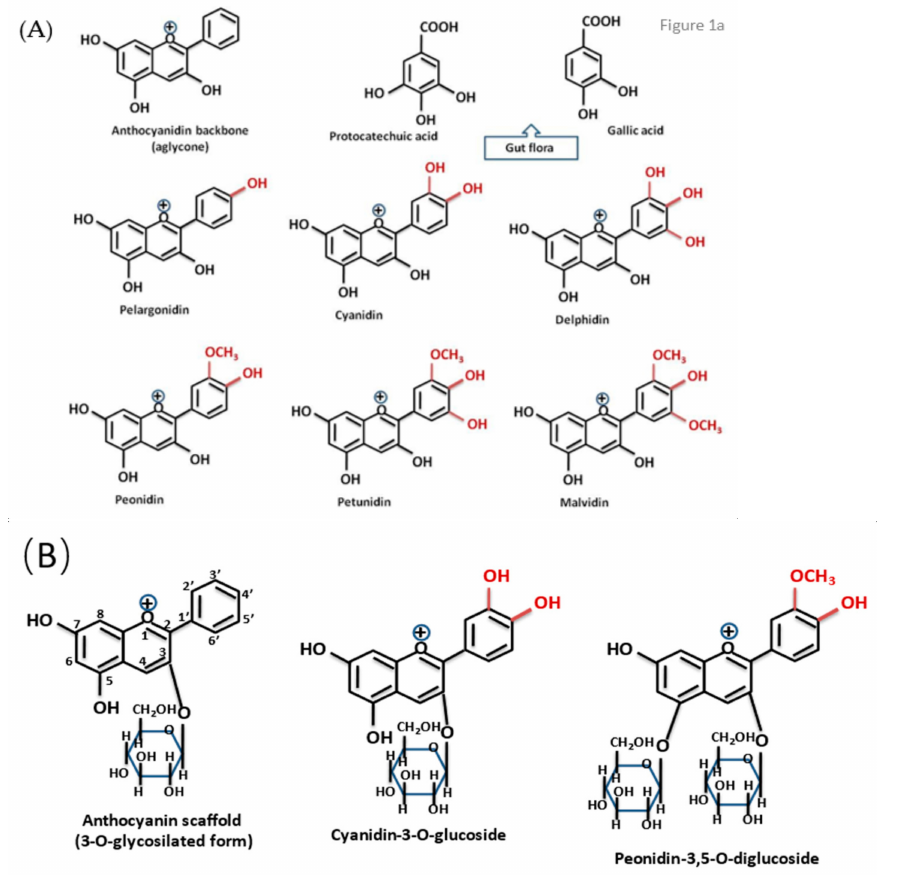
Figure 1. Chemical structures of the most common anthocyanidins ( A ) and their metabolites, and anthocyanins ( B